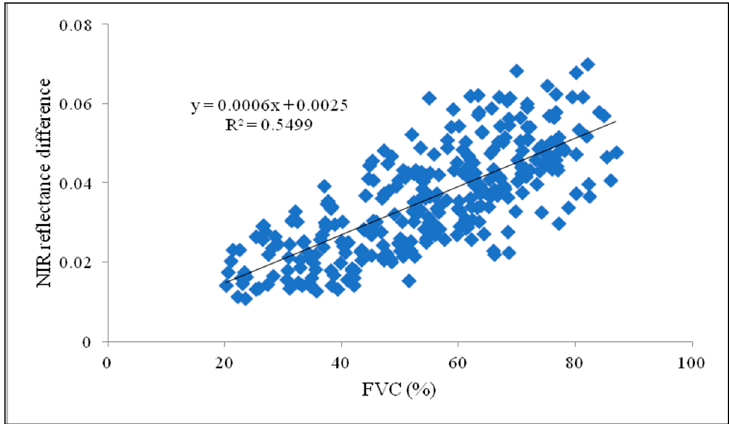
Figure 10. Reflectance difference in NIR band of Landsat 8 image corresponding to different FVCs (the pixels are spot in the map in Figure 1).